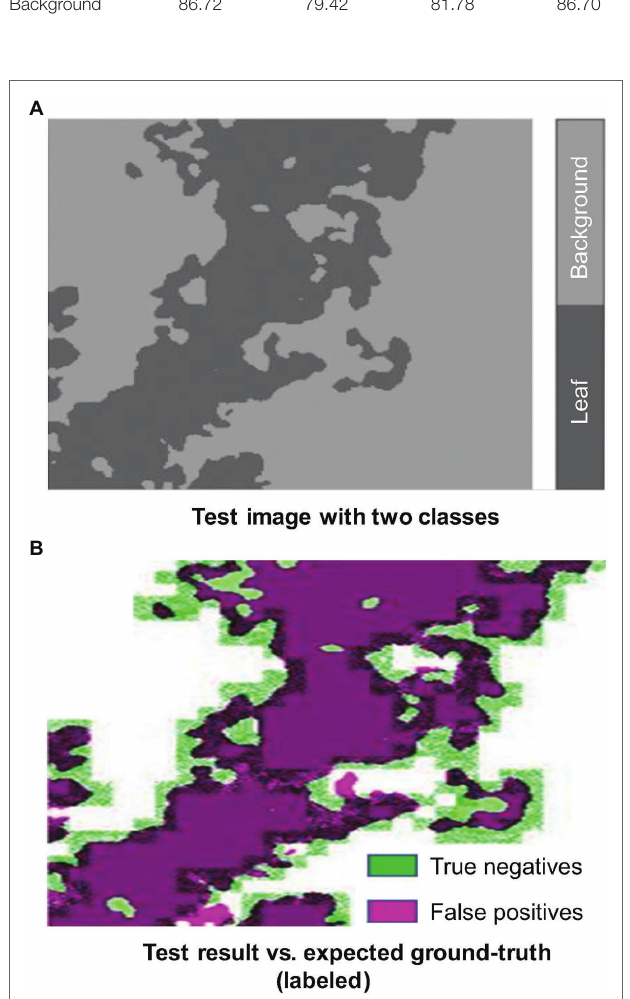
FIGURE 11 | Test image vs. expected ground truth. (A) Test image with two classes. (B) Test results vs. expected ground-truth